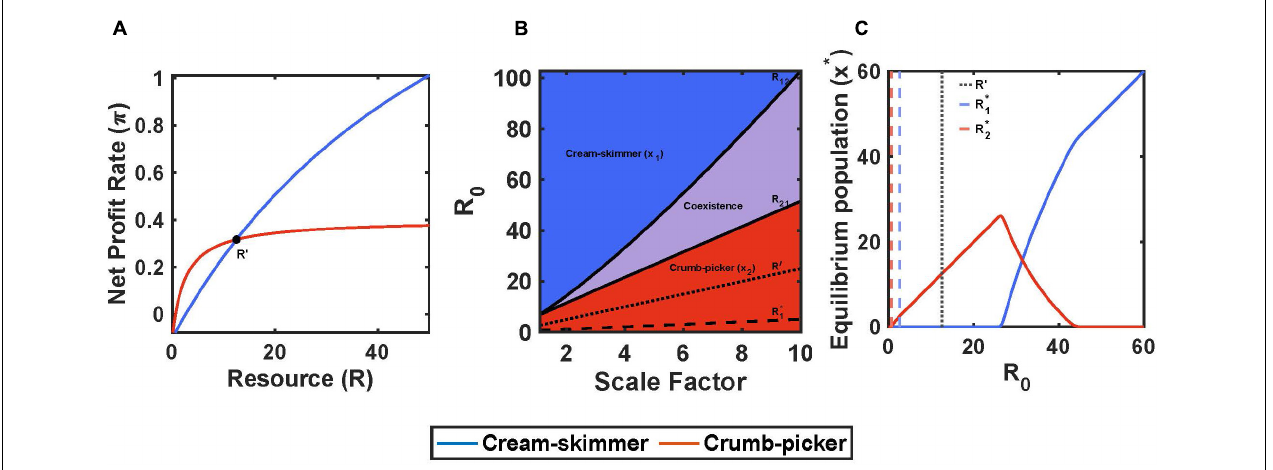
FIGURE 1 | Encounter rate and handling time trade-off with pulsed resource. (A) The crumb-picker has the higher net profit rate than the cream-skimmer at low values of R . R (cid:48) represents the resource level where both species have the same net profit rate. (B) Regions of competitive exclusion and coexistence change due to initial pulse size R 0 and the scale factor µ . (C) For µ = 5, equilibrium populations change as a function of R 0 . Intermediate values of R 0 show species coexistence. Parameters: a 2 = 0.2, a 1 = a 2 / µ , h 2 = 2, h 1 = h 2 / µ , b 1 = b 2 = 0.5, c 1 = 0.1, T = 10, x 1 (0) = 10, x 2 (0) =